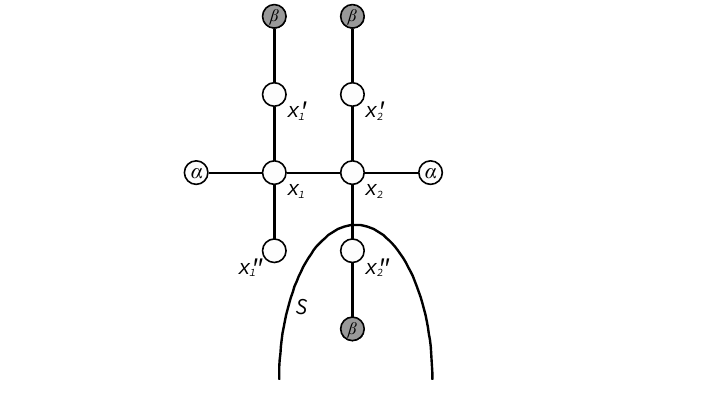
Fig. 4: Region S where Alice might have played is circled and light gray vertices denote possible location for the initial colored vertex v .